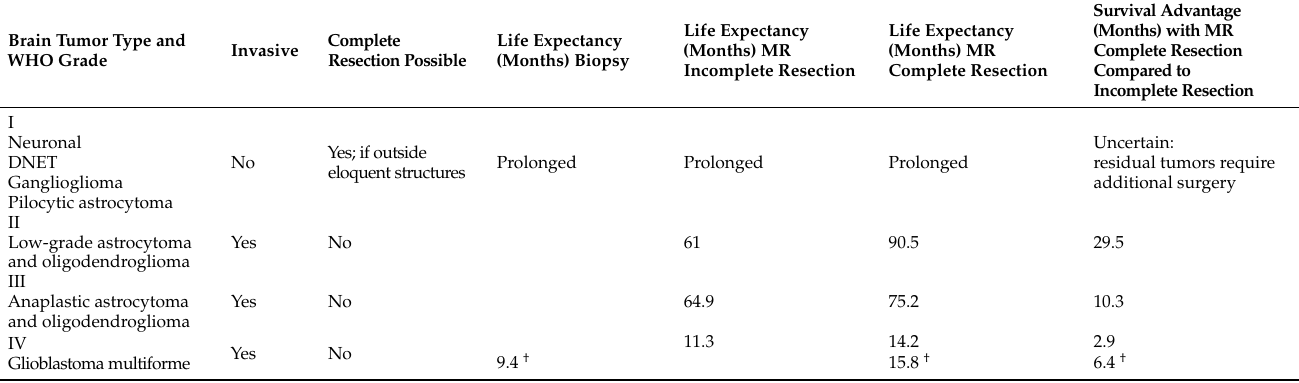
Table 1. Prognostic impact of extent of